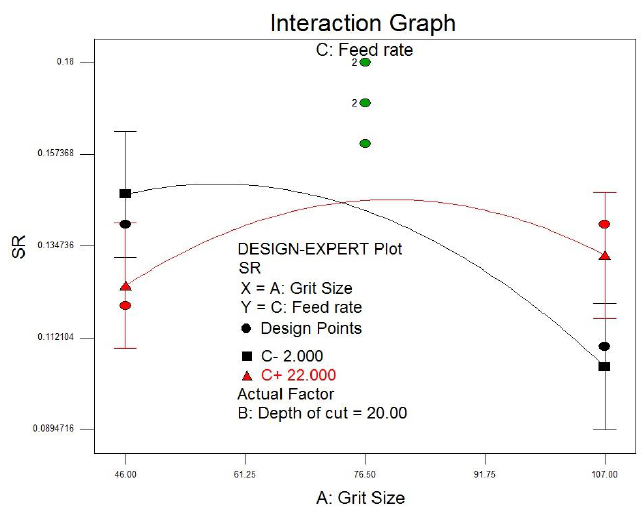
Figure 8: The interaction effect of feed rate and grit size.